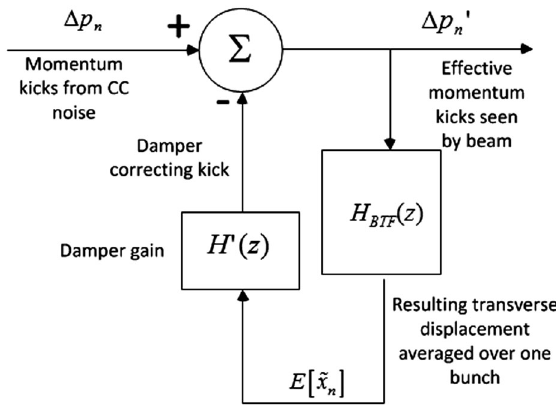
FIG. 5. Momentum kicks and damper